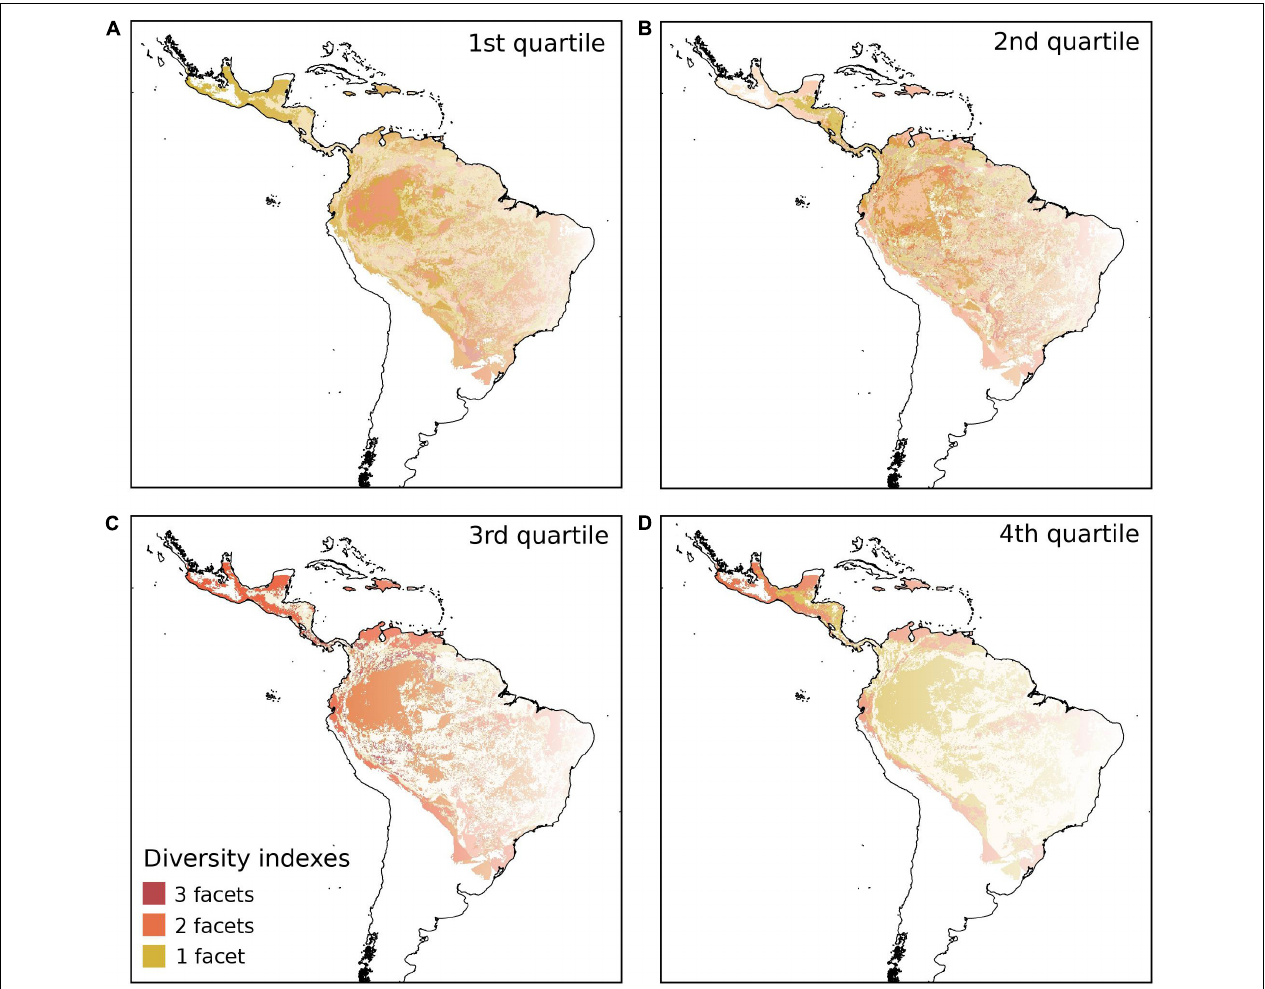
FIGURE 4 | Spatial congruence in taxonomic, phylogenetic and functional diversity measured by Mean Nearest Taxon Distance (MNTD) of cocosoid palm species in the Neotropics, for the four quartiles; 1st quartile (A) , 2nd quartile (B) , 3rd quartile (C) and 4th quartile (D) . Dark red shows 100% of spatial congruence among the three diversity indices, orange shows congruence between two facets two indices, and yellow shows no congruence, i.e., the presence of only one